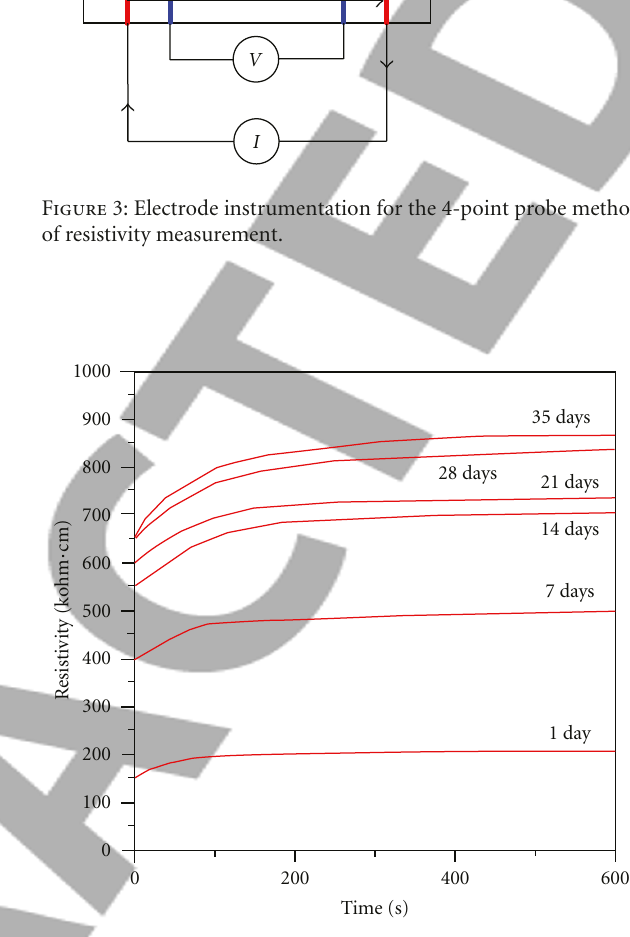
Figure 4: Resistivity measurement of ECC specimens by 4-point